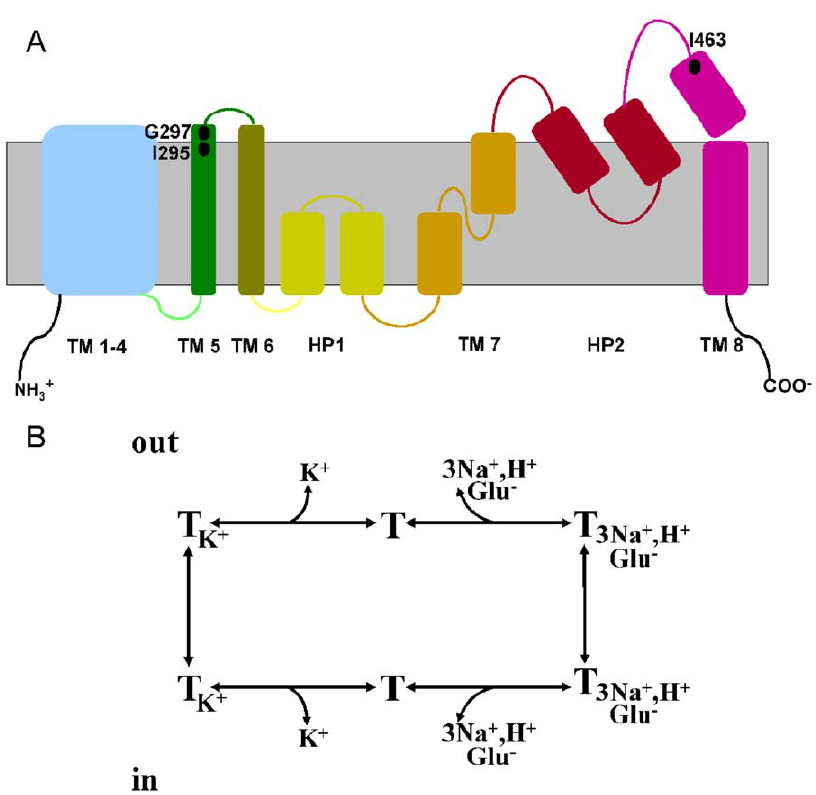
Figure 1. Topology model and transport cycle of GLT-1. ( A ) Topology model of GLT-1 by analogy to that of Glt Ph shown with black dots denotes the approximate locations of the following three cysteine substitutions: I295C, G297C, and I463C. TM helices 1– 8 and hairpins (HP1 and HP2) are labeled. ( B ) Transport cycle of GLT-1. After binding of sodium, glutamate, and a proton from the extracellular medium ( up ), the outward-facing substrate-loaded translocation complex is formed. After the external gate closes, the internal gate opens and the substrate and cotransported ions dissociate into the cytoplasm ( bottom ). Subsequently, intracellular potassium enters the binding pocket. After the internal gate closes, the external gate opens and potassium is released into the extracellular medium.